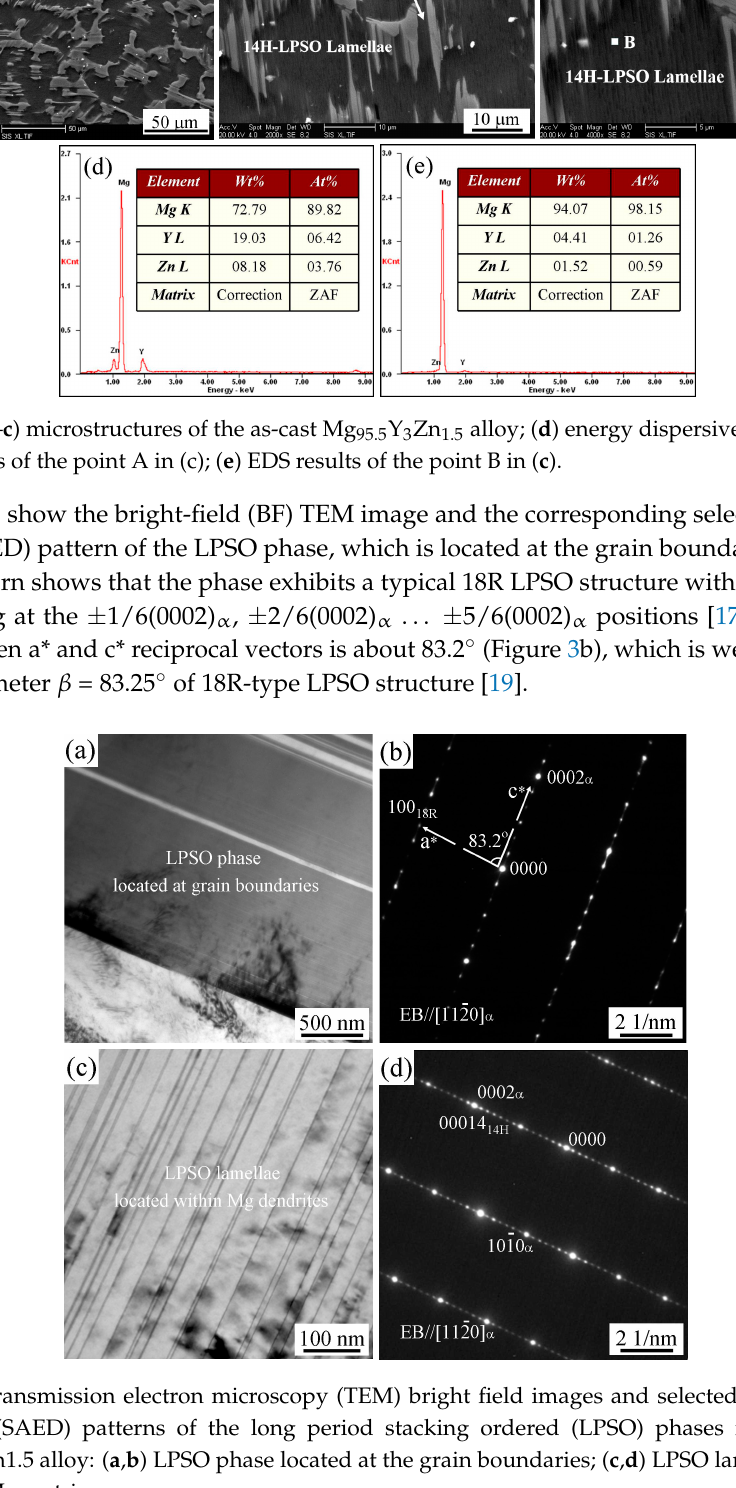
Figure 2. ( a – c ) microstructures of the as-cast Mg 95.5 Y 3 Zn 1.5 alloy; ( d ) energy dispersive spectrometer (EDS) results of the point A in (c); ( e ) EDS results of the point B in (c).